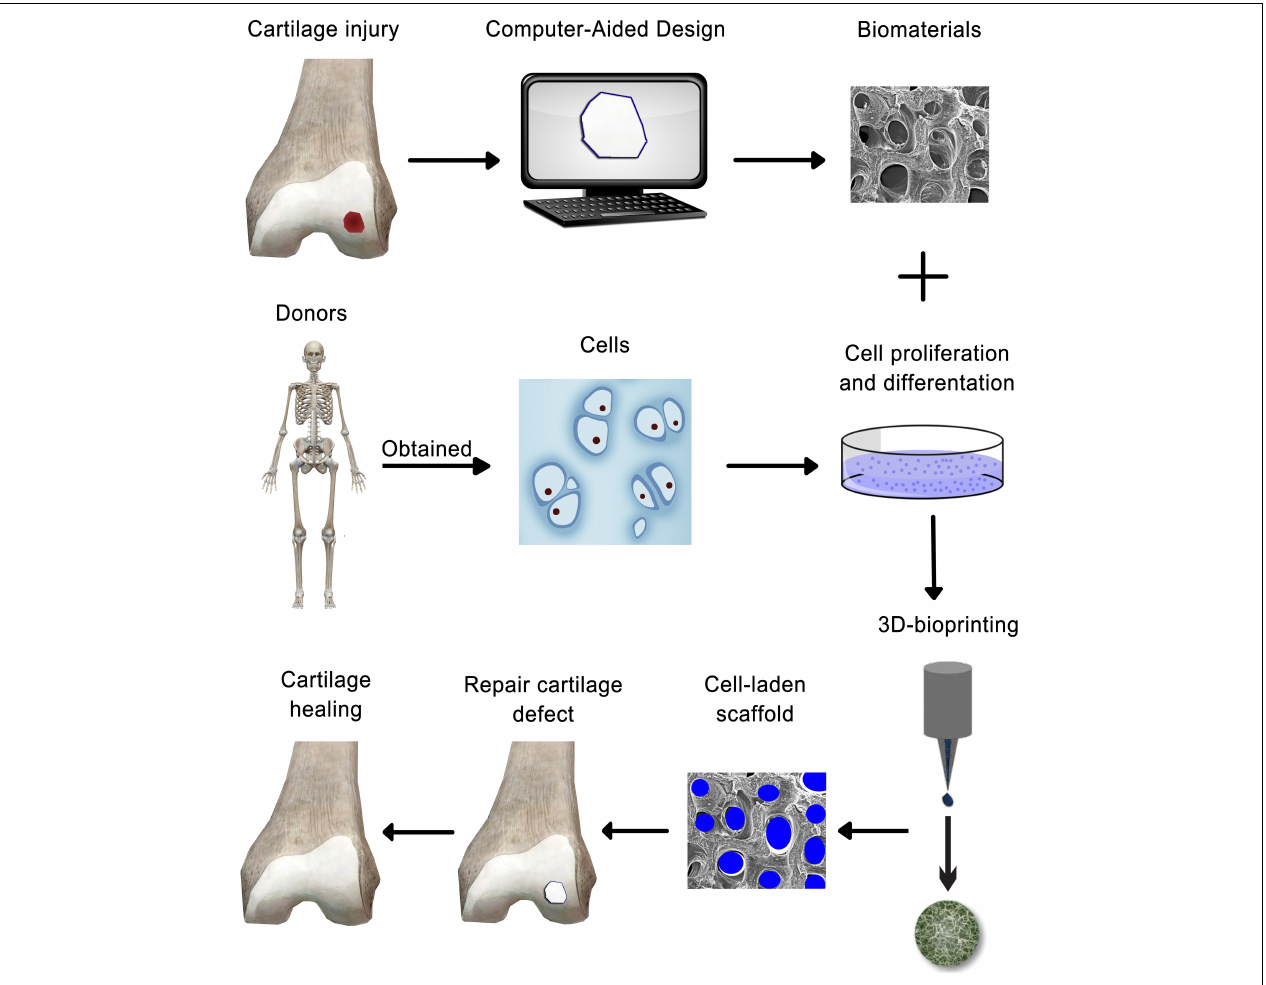
FIGURE 3 | Schematic representation of 3-D bioprinting technology-based cartilage tissue